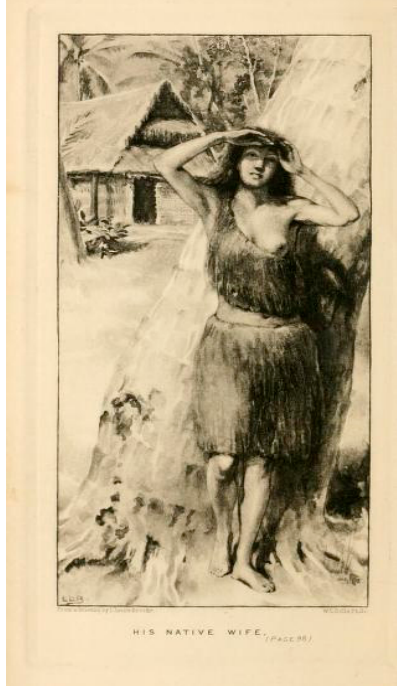
Figure 2. His Native Wife by Louis Becke 1896.